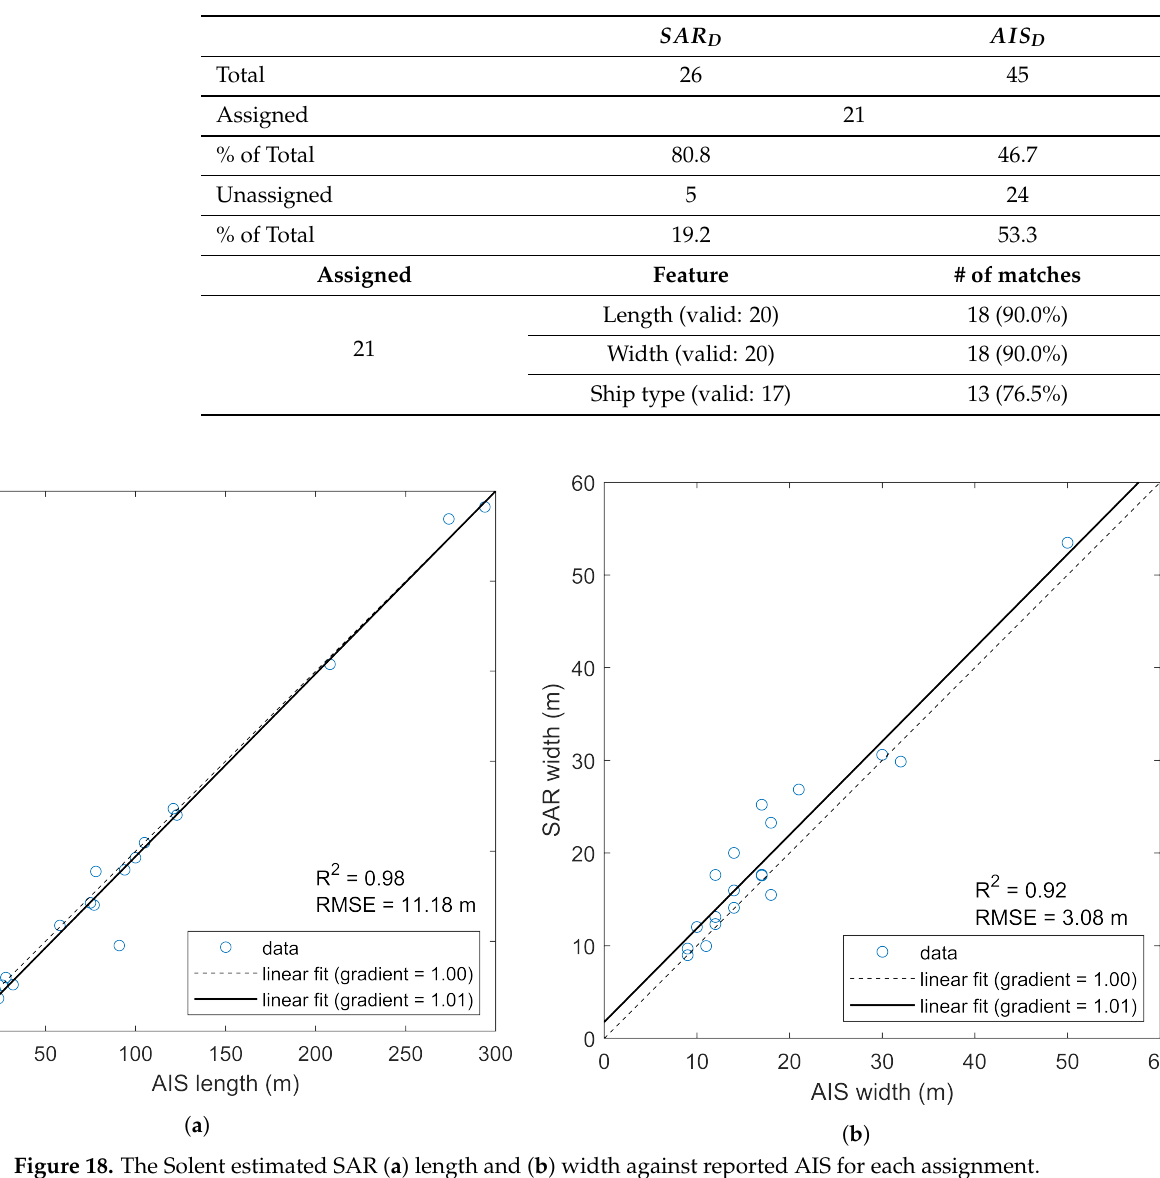
Table 10. The Solent total number of (top) assignments and unassignments (bottom) features in agree- ment.